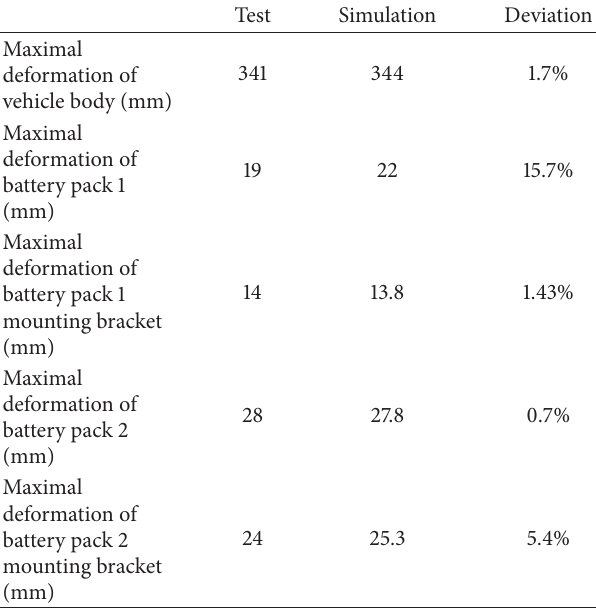
Table 10: The rear-end collision test of E-REV after lightweighting the main